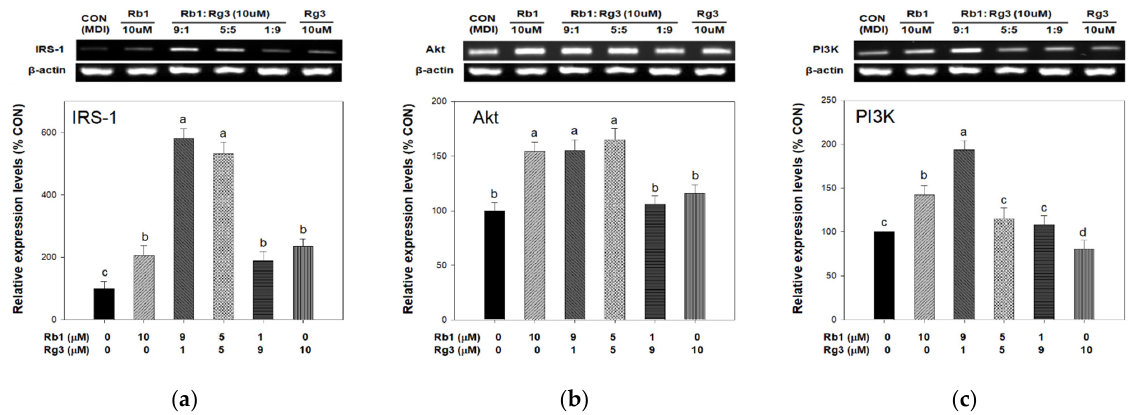
Figure 6. Effect of combined ginsenosides Rb1 and Rg3 on the expression of IRS-1, Akt, and PI3K mRNAs during the differentiation of 3T3-L1 preadipocytes. Values are the means ± SDs of four samples. a–d Bars with different letters indicate statistically significant differences among groups at p < 0.05.